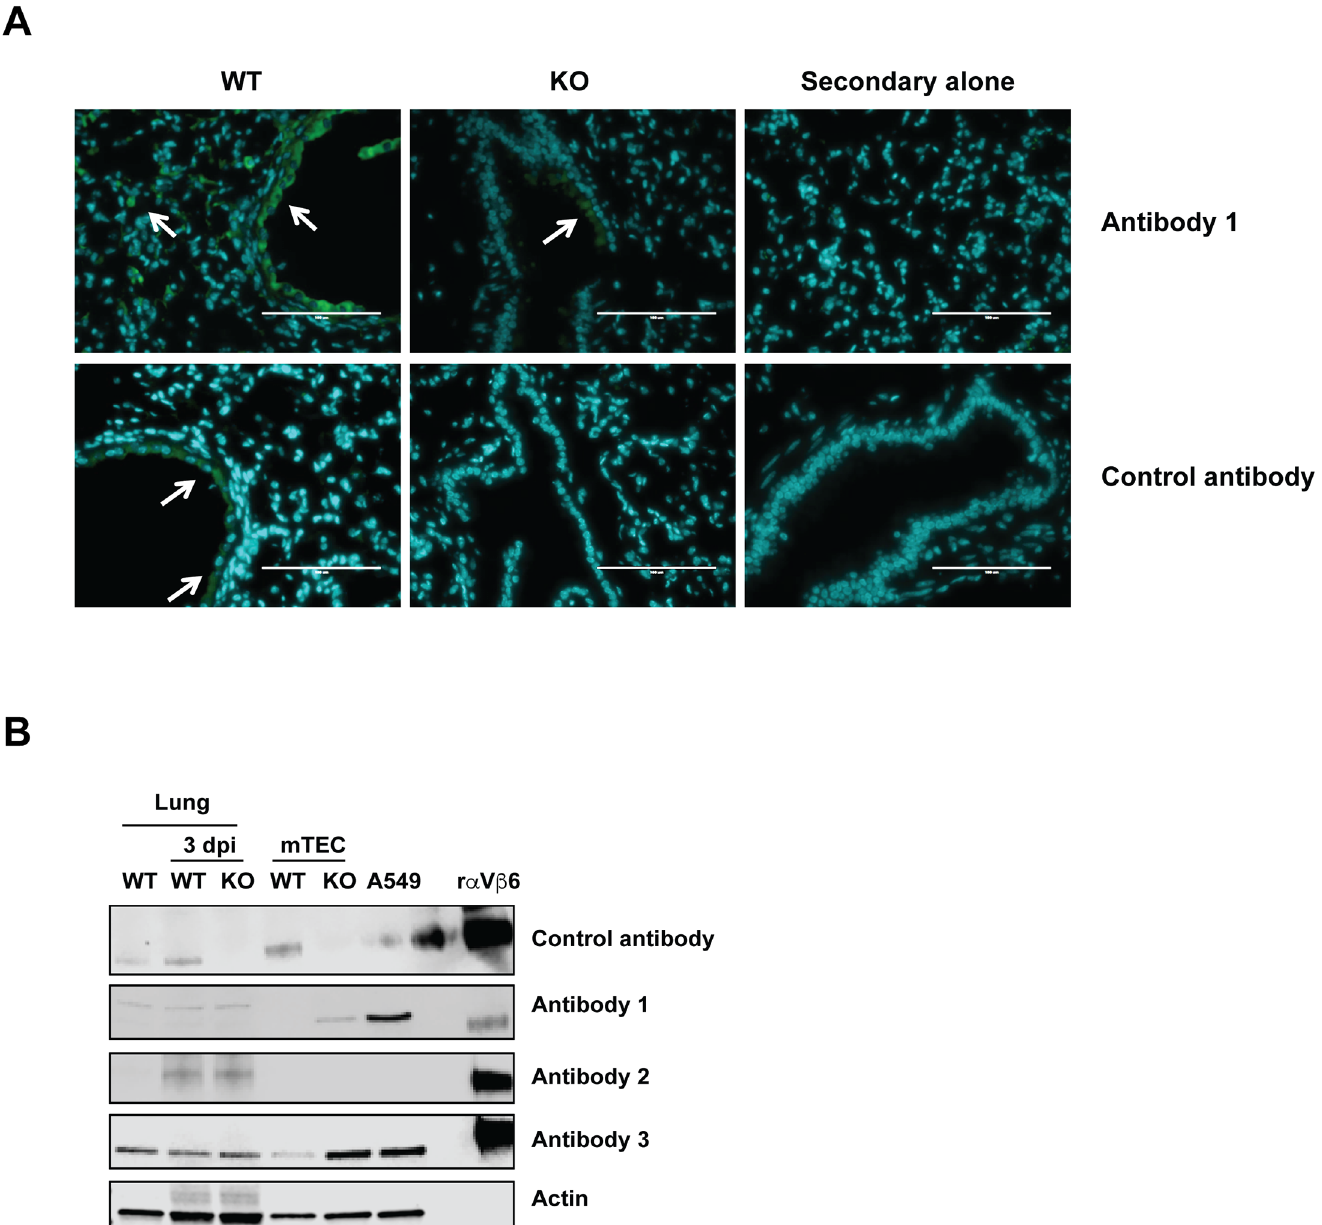
Fig 1. Specificity of β 6 antibodies in immunofluorescent microscopy and western blot analysis. (A) Mouse lung sections collectedat 3 dpi were stained for β 6. Arrows indicate areas of β 6 expression. Green = β 6; blue = nuclei.Bar is 100 μ m. (B) Lysates preparedfrom lung tissue or tracheal epithelialcells were immunoblotted to detect β 6 by using a panel of antibodies. β 6, β 6 integrin; dpi, days post infection; KO, knockout; mTEC, murine tracheal epithelialcell; WT, wild